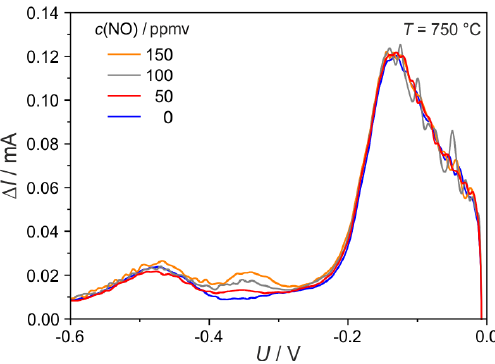
Figure 11. SWV peak height dependency on temperature and NO concentration dependency; other experimental conditions as de- clared in Fig.